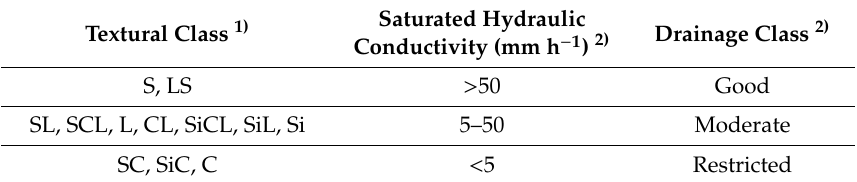
Table 3. Drainage classes in relation with textural class and saturated hydraulic conductivity (systematized after [15] and [47–49]).